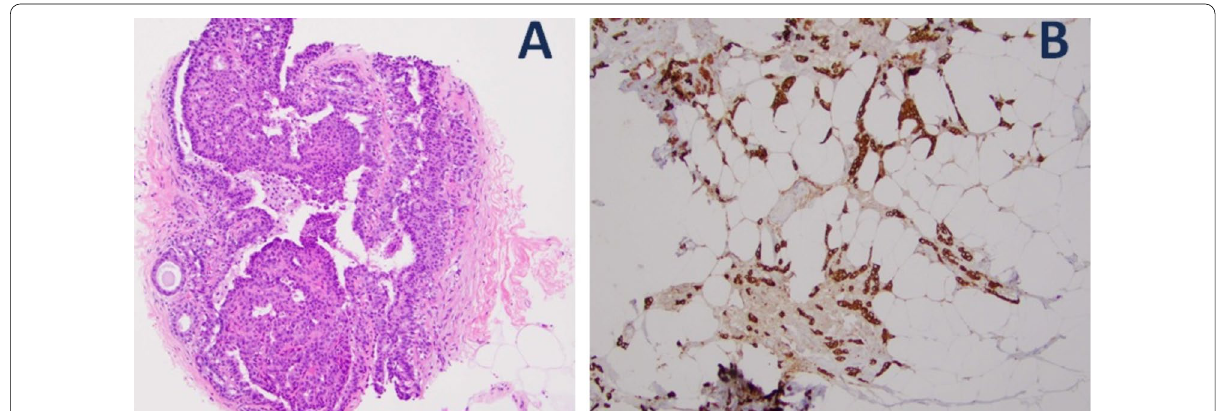
Fig. 2 Core biopsy with a small intraductal papilloma, H&E stain, 100 lobular carcinoma infiltrating adipose tissue, 100